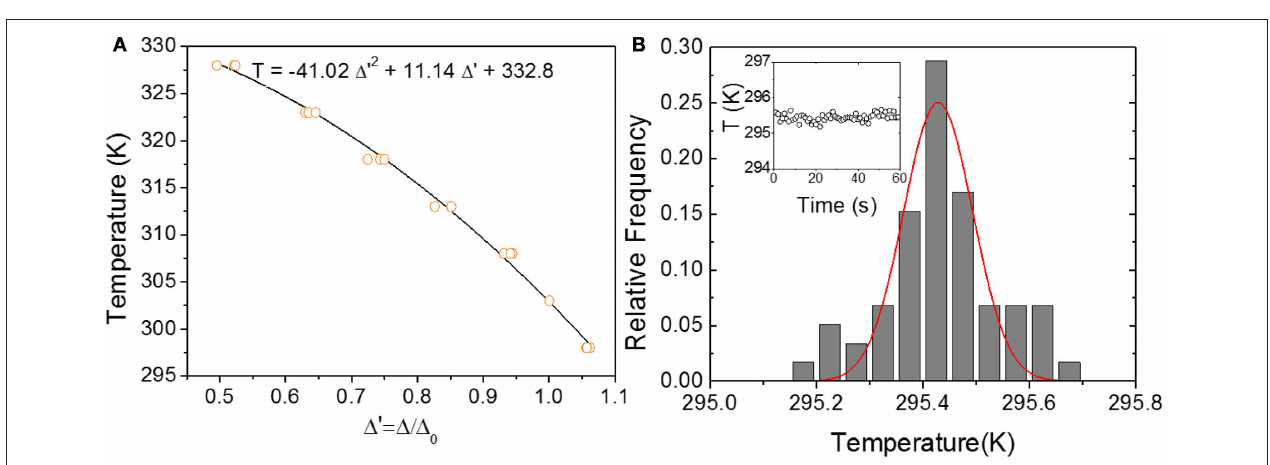
FIGURE 2 | (A) Temperature dependence of the emission spectra of UET–1.3 (excited at 365nm) in the 10–330K temperature range. The f-f lines corresponding to the 5 D 4 → 7 F 6 , 5 (Tb 3 + ) and 5 D 0 → 7 F 2 − 4 (Eu 3 + ) transitions are identified. In the area marked with an asterisk